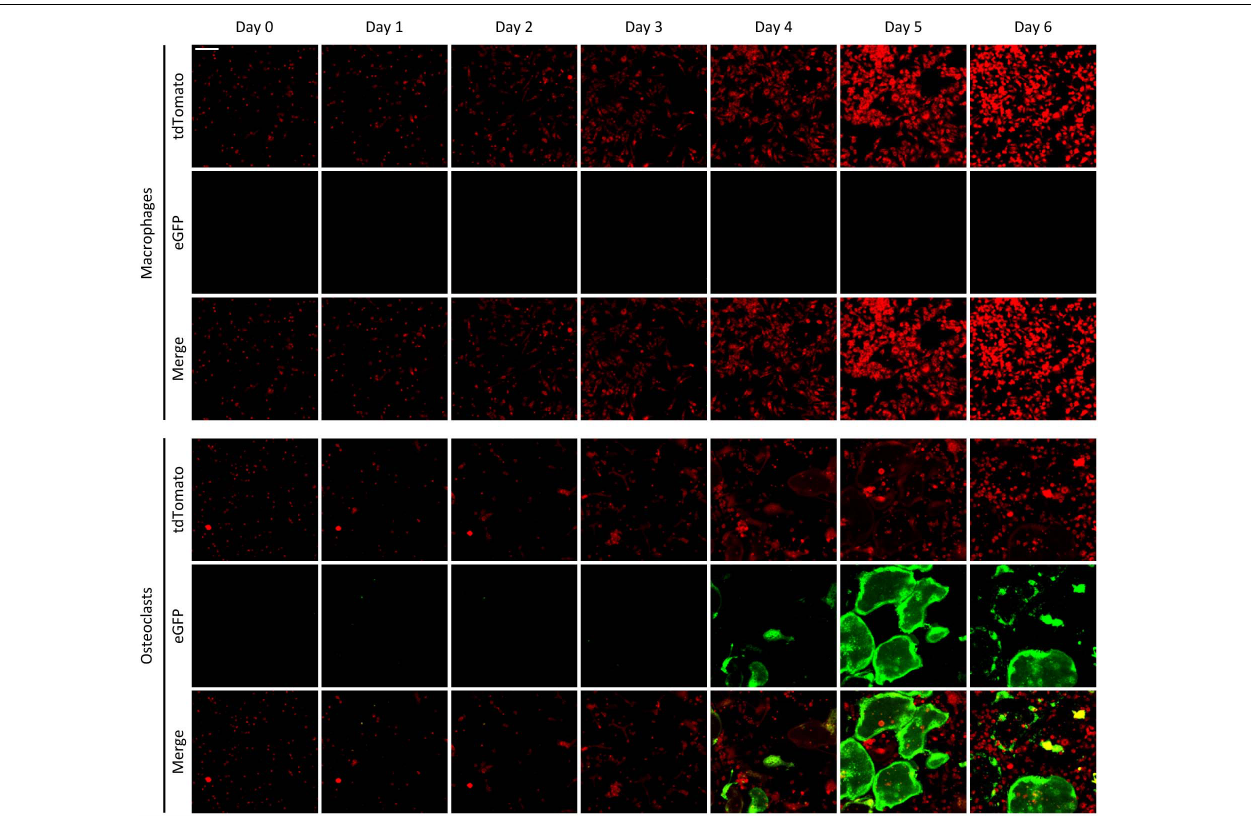
FIGURE 7 | The time-course of fluorescence changes in the FRAMCO1.2 assay. Representative images of Ctsk-Cre + mTmG macrophage and osteoclast co-cultures captured on the indicated days after RANKL addition. Red and green channels supposedly correspond to the indicated fluorophores. The scale bar corresponds to 100 µ m and applies to all images. Images are representative of 8–10 independent